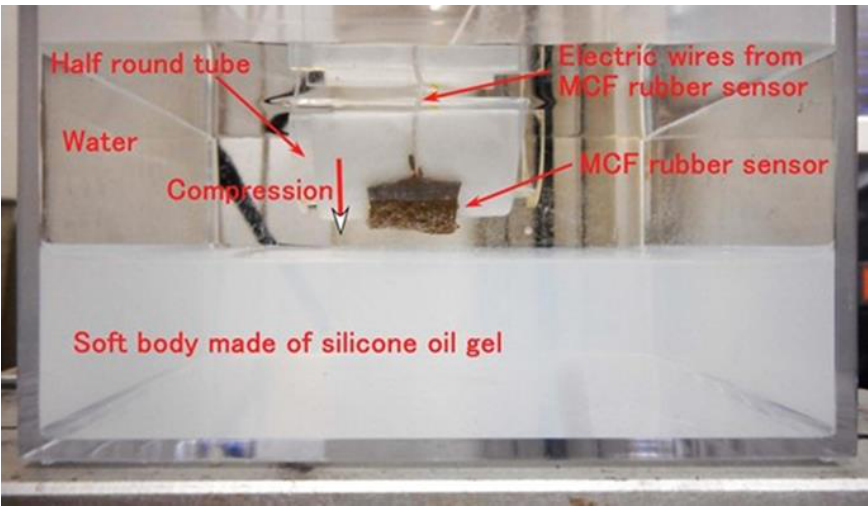
Figure 15. Corresponding image of the schematic shown in Figure 14.